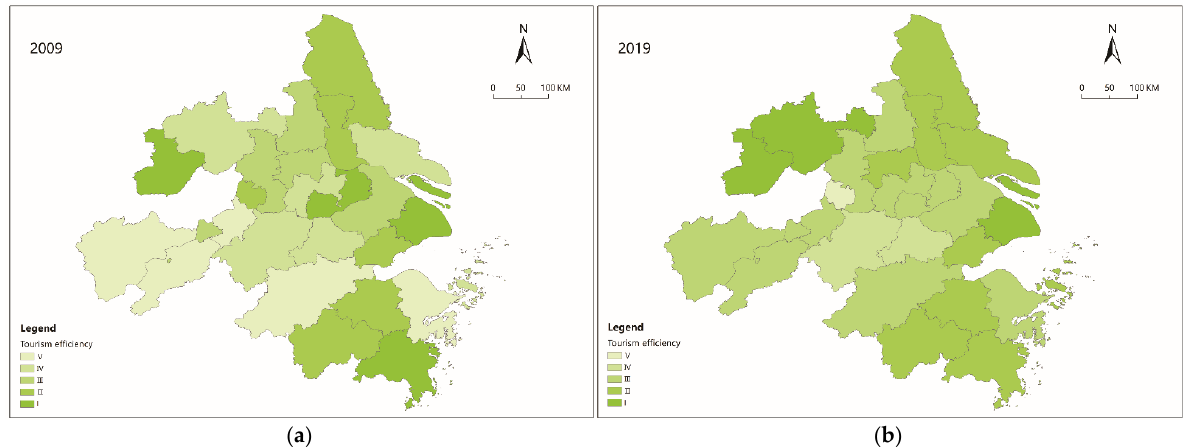
Figure 1. Evolution of spatial differences in tourism eco-efficiency in ( a ) 2009 and ( b ) 2019.